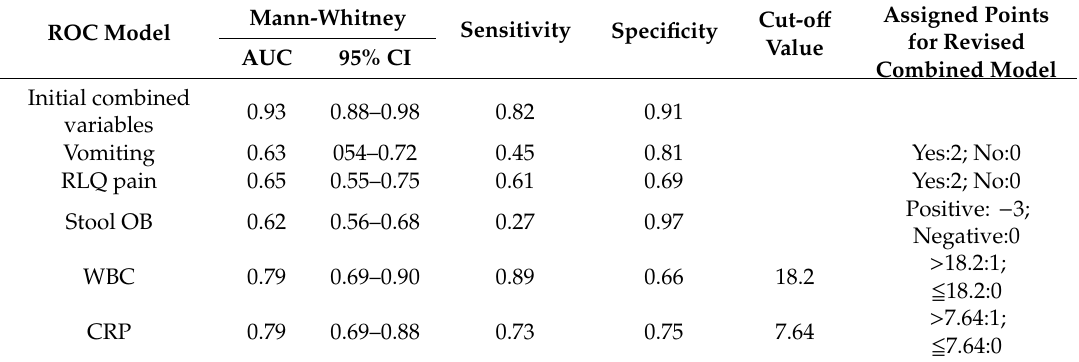
Table 4. Different variables and initial combined variables receiver operating characteristic (ROC) models associated with acute appendicitis.